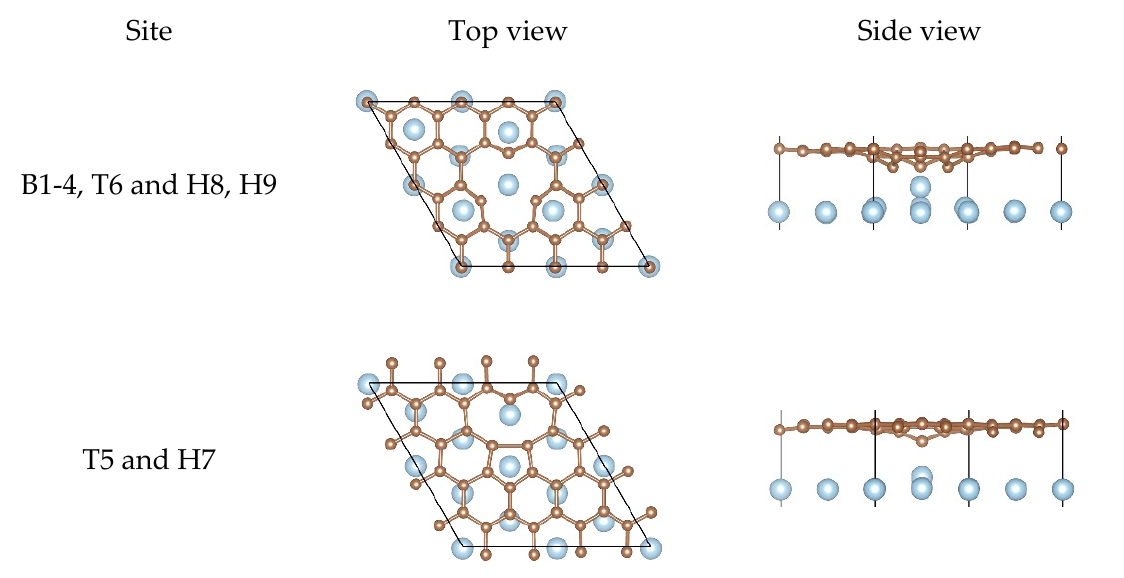
Figure 4. Top views and side views of the SV graphene on the Al (111) surface after the structural optimization.